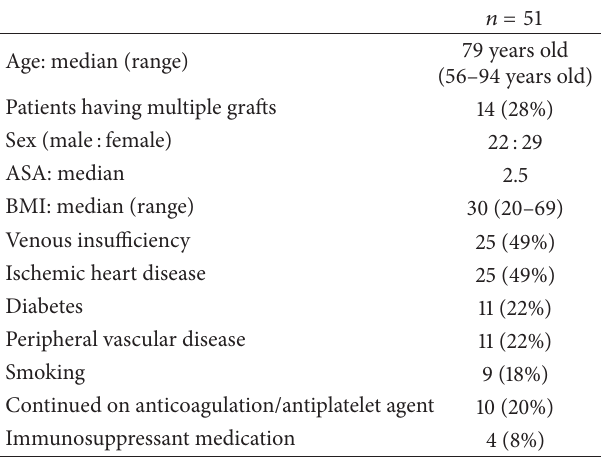
Table 1: Baseline factors of patients having lower limb skin grafts, data presented as ( 𝑛 , %) unless otherwise stated.